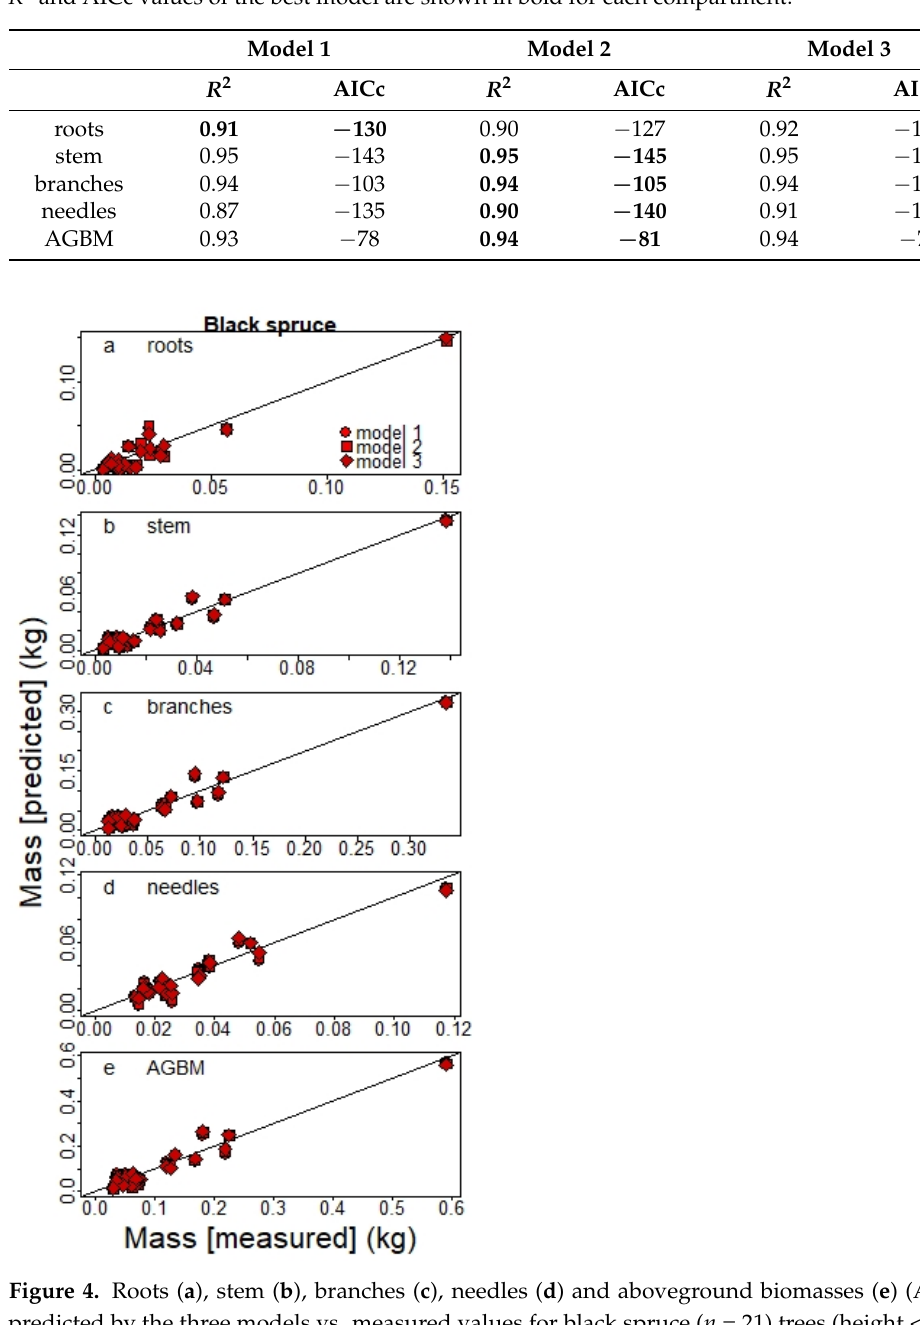
Table 4. Comparison of fitting performances ( R 2 and AICc) of the three models for needles, branches, stem, roots and aboveground biomass (AGBM) in black spruce ( n = 21) trees with height < 1.3 m. R 2 and AICc values of the best model are shown in bold for each compartment.